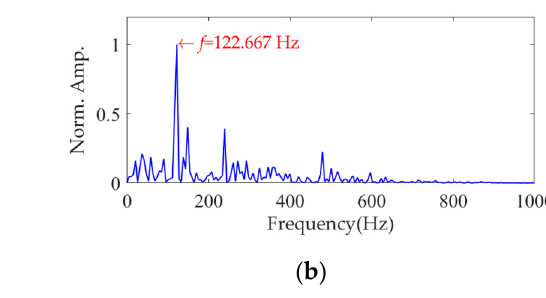
Figure 7. The optimal target mode: ( a ) time − domain waveform and ( b ) SES.